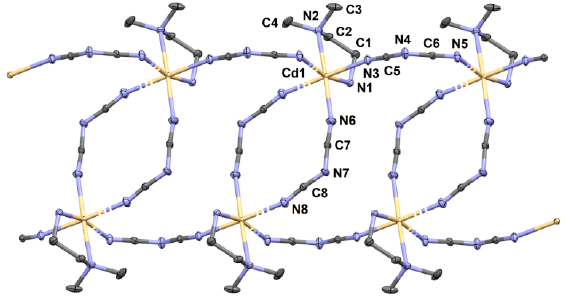
Figure 4. One-dimensional double chains in complex 4 . (Color code: yellow, Cd; blue, N; black, C.)